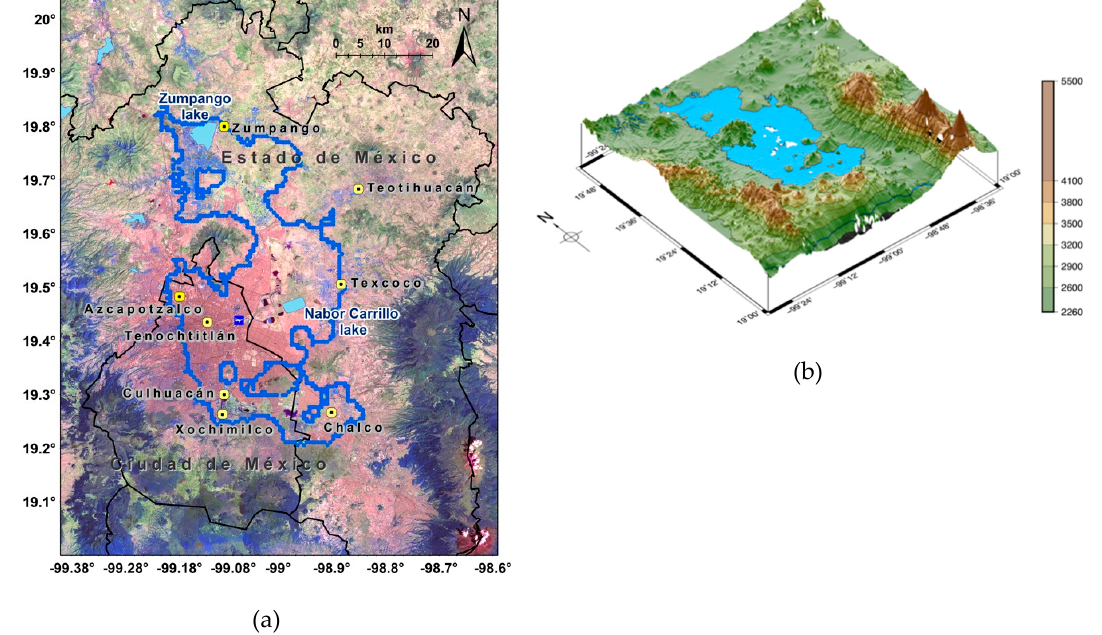
Figure 1. ( a ) LANDSAT image of the Valley of Mexico and the surrounding area. Black lines are the state borders and the blue line shows the limits of the area covered by an ancient lake (simulated). The corresponding sites used in the analysis are marked with yellow squares: Teotihuacan (TEO), Tenochtitlan (TEN), Texcoco (TEX), Xochimilco (XOC), Chalco (CHA), Culhuacán (CUL), and Zumpango (ZUM). ( b ) Digital elevation model of the valley with a representation of the area covered by the ancient lake [3]. Elevation is in meters according to the color bar.